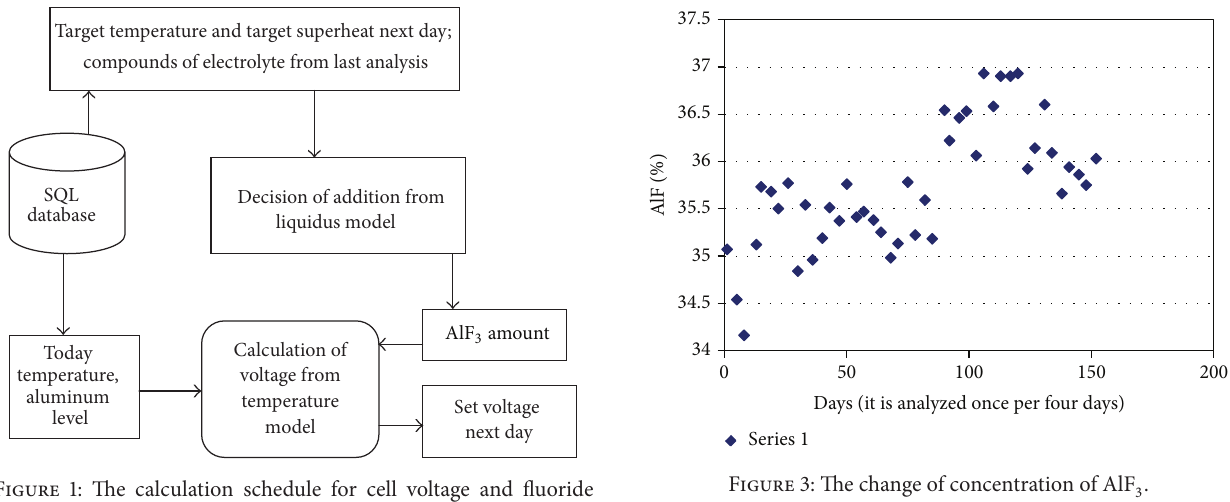
Figure 1: The calculation schedule for cell voltage and fluoride addition amount.